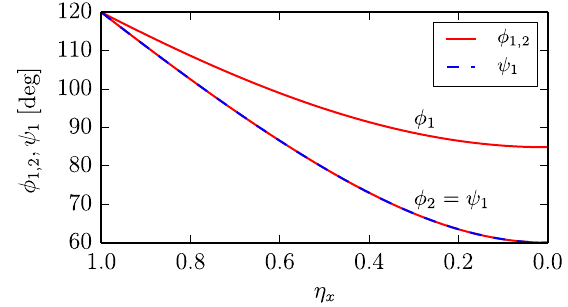
FIG. 1. Round beam case, k 0 ;x ¼ k 0 ;y ¼ k 0 ¼ 60 °: Phase shifts ϕ ψ 1 ; 2 , 1 versus tune depression in channel.